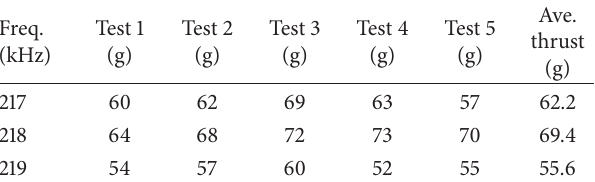
Figure 9: Thrust measurement experiment. Table 4: Thrusts of piezoelectric actuator containing single pusher (preload of 215g, drive voltage 30Vpp).